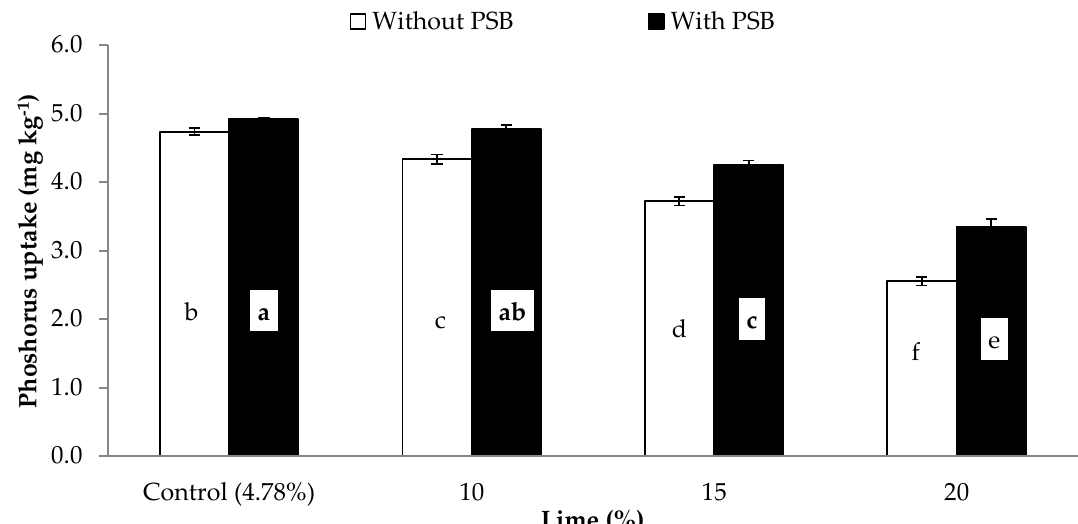
Figure 6. Maize P uptake (mg kg −1 ) in response to the integration of lime and PSB on of maize. Bars sharing letters are statistically comparable at p < 0.05 according to least significance difference (LSD) test. Error bars show standard error (n = 3).